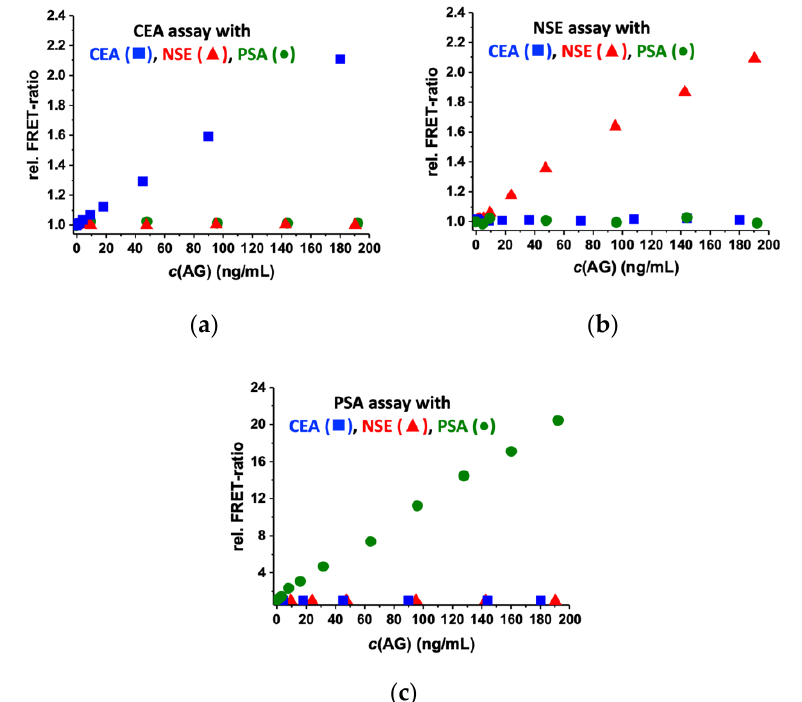
Figure 5. Biological crosstalk evaluation of different AB FRET pairs against different AGs. FRET immunoassay calibration curves for different AG (CEA, NSE, and PSA) concentrations using: ( a ) the antiCEA AB FRET pair measured in the eQD650 detection channel; ( b ) the antiNSE AB FRET pair measured in the eQD605 detection channel; and ( c ) the antiPSA AB FRET pair measured in the iQD705 detection channel.